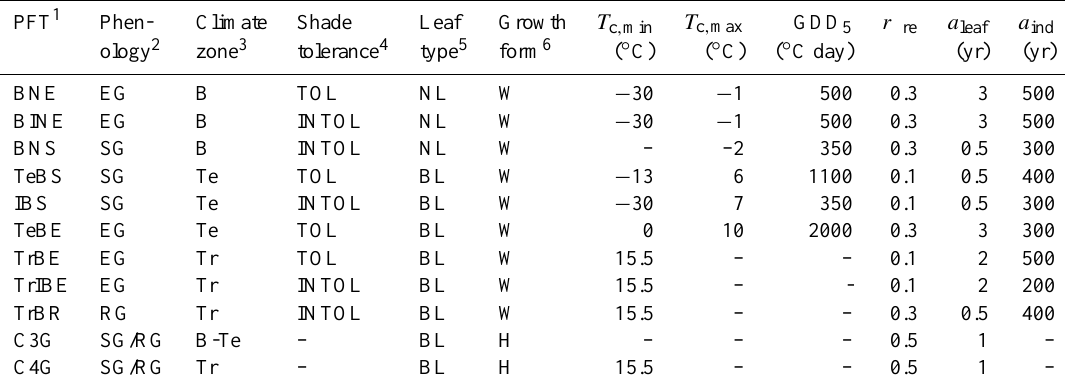
Table B1. PFT characteristics and parameter values adopted in this study. Additional parameters specific to the C–N version of LPJ-GUESS are presented in Appendix C. Parameters common to the climate zone, shade tolerance, leaf type and growth form categories distinguished are shown in Table B2. T c , min =minimum coldest-month temperature for survival and establishment; T c , max =maximum coldest-month temperature for establishment; GDD 5 =minimum degree-day sum above 5 ◦ C for establishment; r fire =fraction of individuals surviving fire; a leaf =leaf longevity; a ind =maximum expected non-stressed